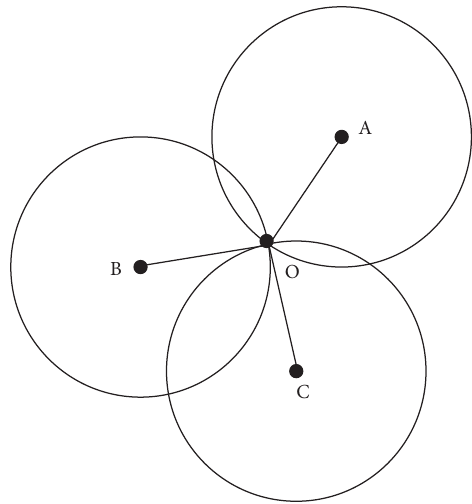
Figure 1: Schematic diagram of three-side measurement location.